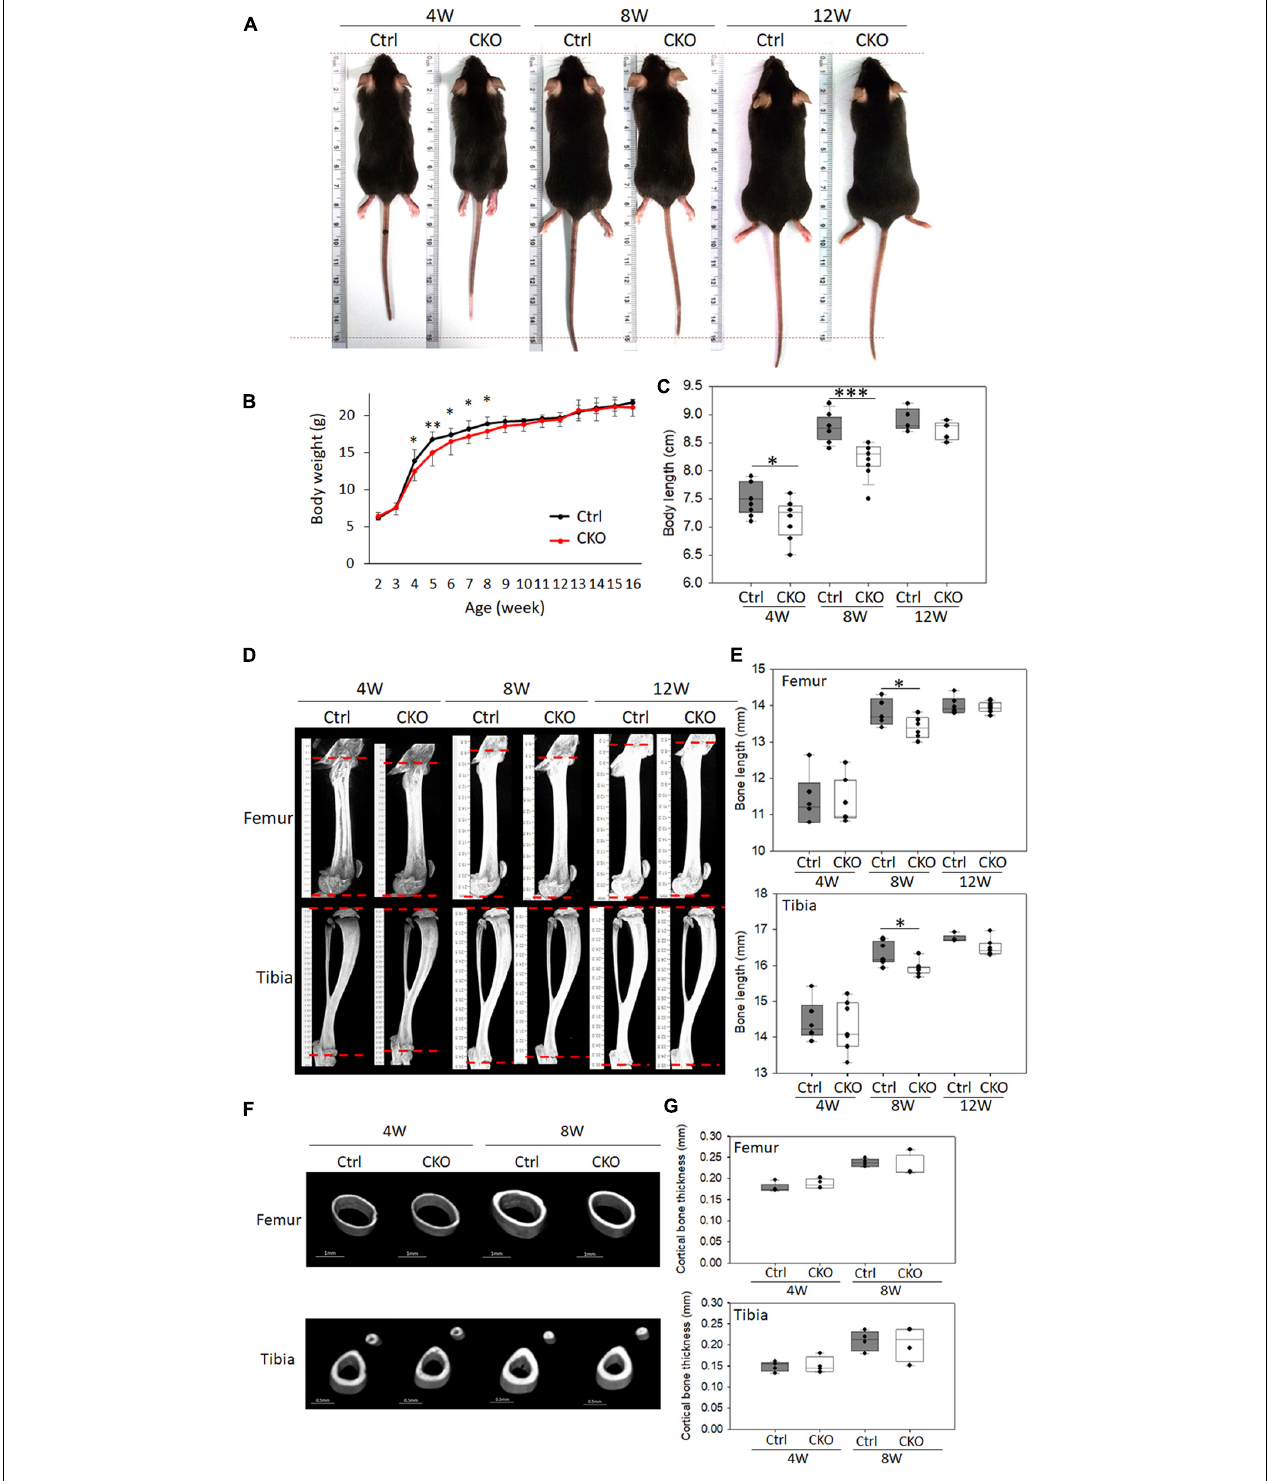
FIGURE 3 | Comparison of phenotypes between chondrocyte-specific GPER-1 knockout mice (CKO) and control mice (Ctrl). (A) General appearance of 4-, 8-, and 12-week-old female mice. (B) Body weight of CKO and Ctrl mice. (C) Body length (crown–rump length) of CKO and Ctrl mice. (D,E) Femur and tibia µ -CT images and length quantitation in 4-, 8-, and 12-week-old CKO and Ctrl mice. (F,G) Cortical bone thicknesses were analyzed via µ -CT. Each group, N = 6–8. ∗ P < 0.05, ∗∗ P < 0.01, ∗∗∗ P < 0.001.